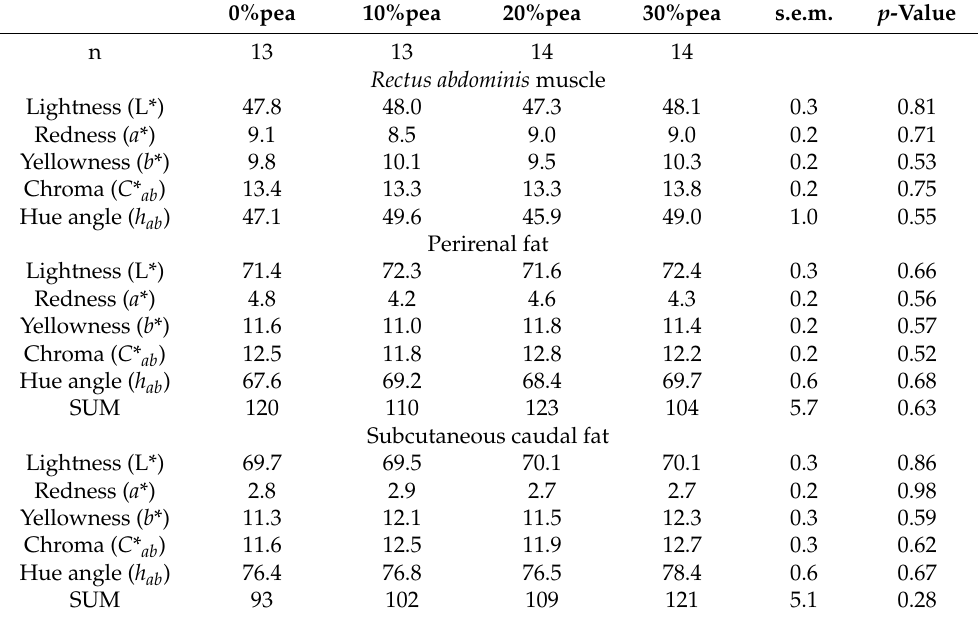
Table 2. Effect of the proportion of pea in the concentrate on the colour and the estimator of carotenoids (SUM) of Rectus abdominis muscle, subcutaneous fat and perirenal